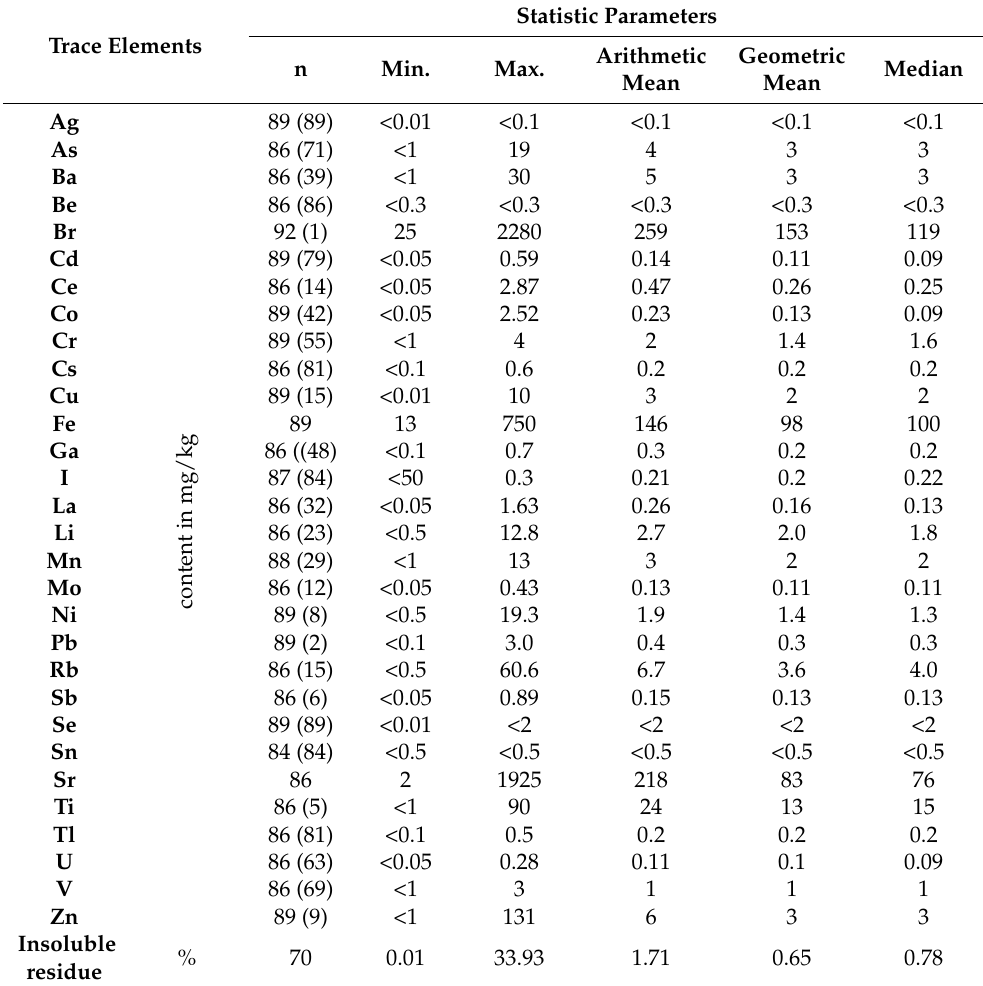
Table 6. Statistic parameters of trace element content in the potash-bearing deposits of PZ2 cyclothem in Poland.